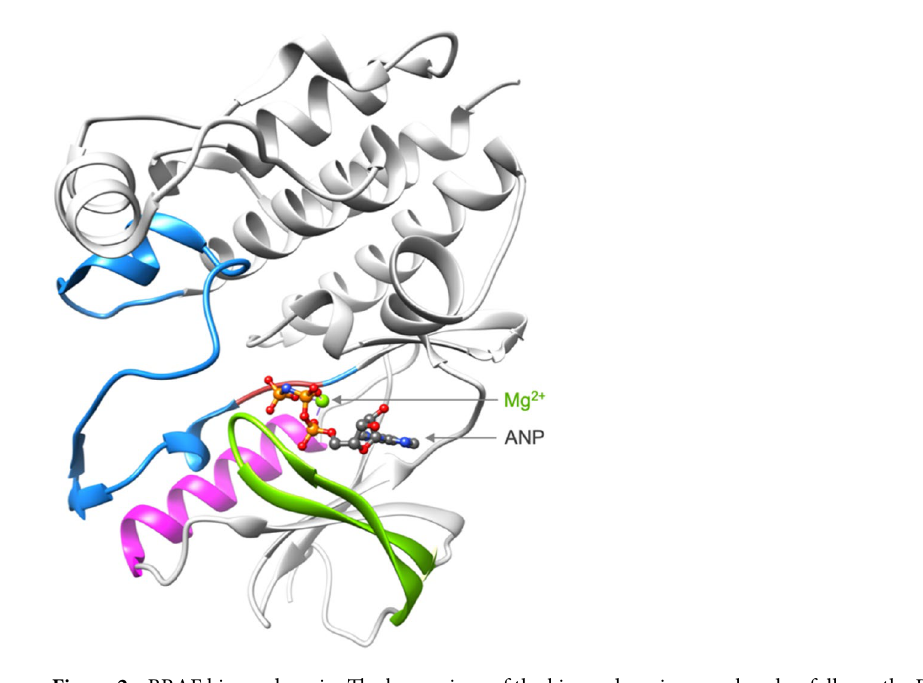
Figure 2. BRAF kinase domain. The key regions of the kinase domain are colored as follows: the P-loop in green, the C-helix in magenta, the activation loop in blue and the kinase DFG motif in crimson. This BRAF structure is extracted from the complex BRAF:MEK (pdb code: 6pp9) 12 . The BRAF kinase is co-crystallized in the presence of Mg 2+ and ANP, which is an ATP